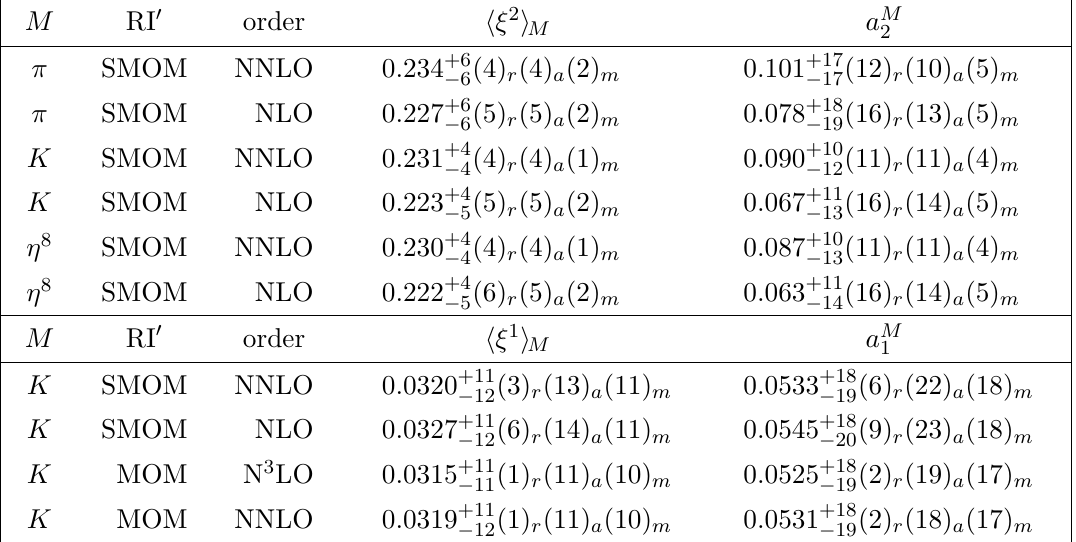
Table 3 . Continuum limit extrapolated values for the (cid:12)rst two moments of the octet mesons. The results have been converted to the MS scheme at (cid:22) = 2 GeV using intermediate RI 0 schemes and di(cid:11)erent loop orders in the perturbative matching. The statistical error given as sub- and superscript re(cid:13)ects the errors of the data after extrapolation. The numbers in parentheses give estimates of the systematic uncertainties due to the nonperturbative renormalization ( r ) as described in section 2.3, the continuum extrapolation ( a ), and the chiral extrapolation ( m ). As discussed in section 3.1, (cid:12)nite volume e(cid:11)ects are negligible in our